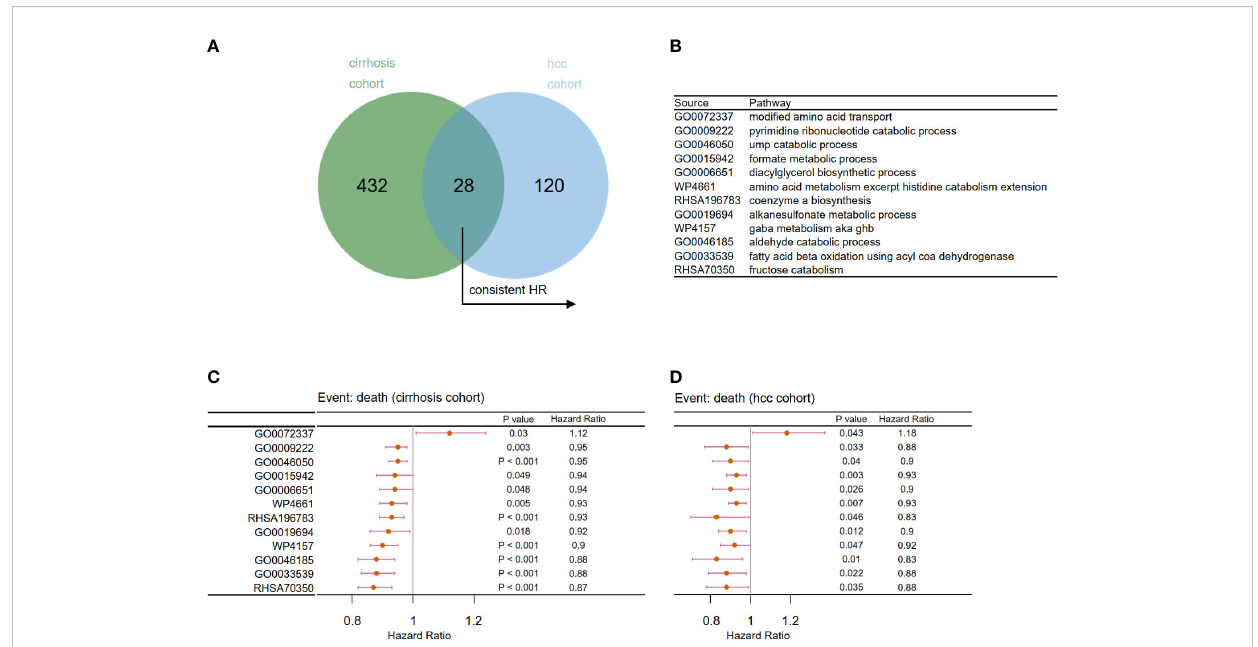
FIGURE 5 Filtration of prognosis-related metabolic pathways. (A) Venn diagram to identify 28 overlapping prognosis related-metabolic pathways. (B) Related metabolic pathways in panels C and D . Forest plot of univariate Cox analysis for the chosen prognosis-related metabolic pathways in (C) Cohort 2 and (D) Cohort 3 (p < 0.05).